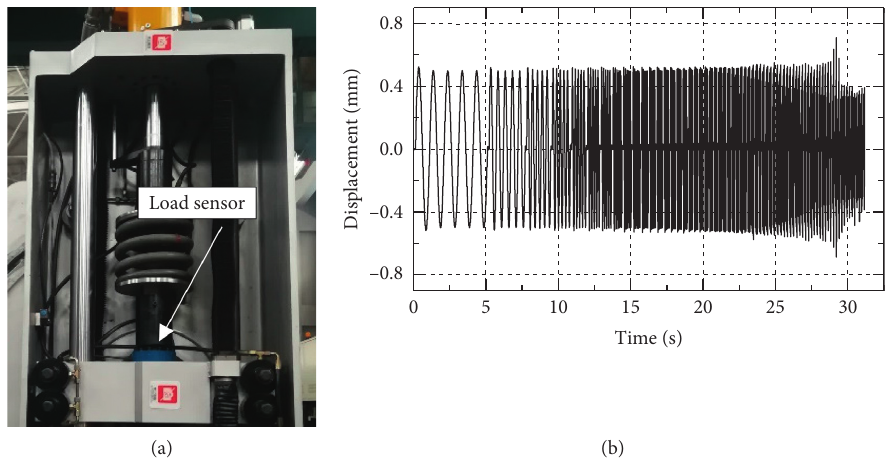
Figure 8: Dynamic stiffness test of coil spring. (a) Dynamic stiffness test bench. (b) Sweep excitation of displacement. –8–6–4–20246 N ) ( k c e o r F